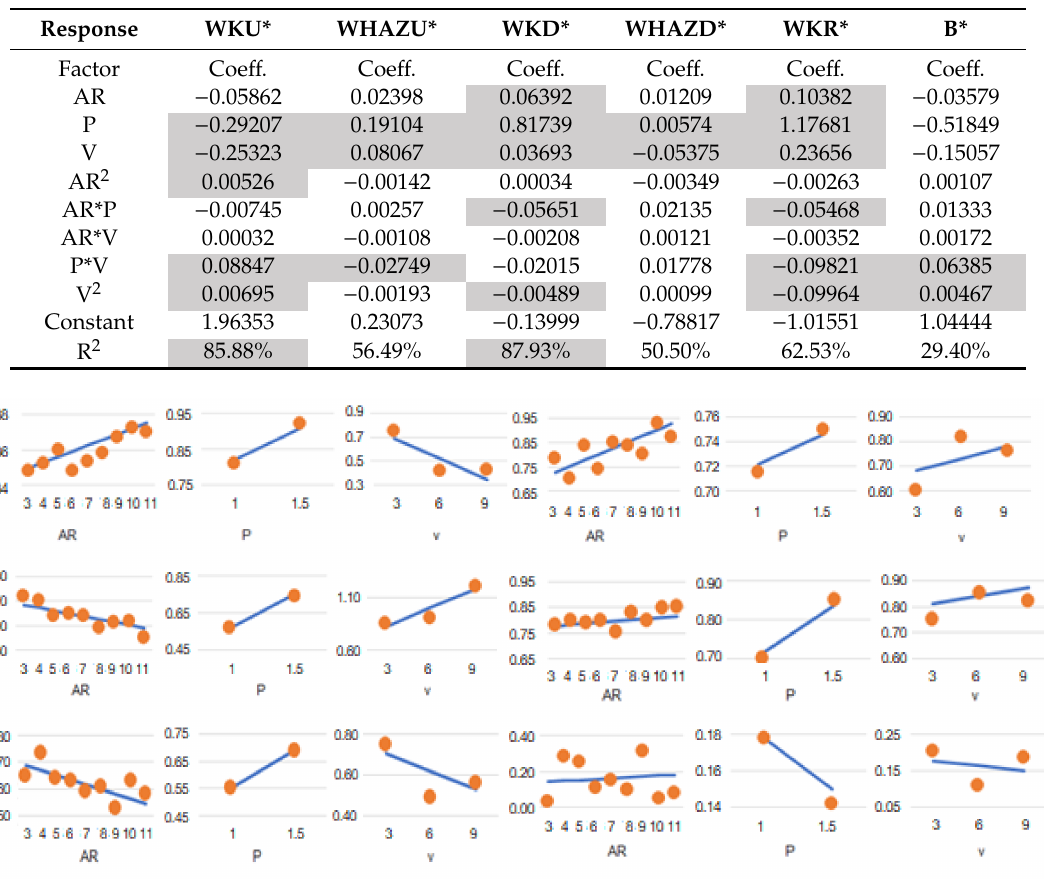
Figure 3. Influence of the main factors: First line (left) WKU* and (right) WHAZU*; second line (left) WKD* and (right) WHAZD*; and last line (left) WKR* and (right)